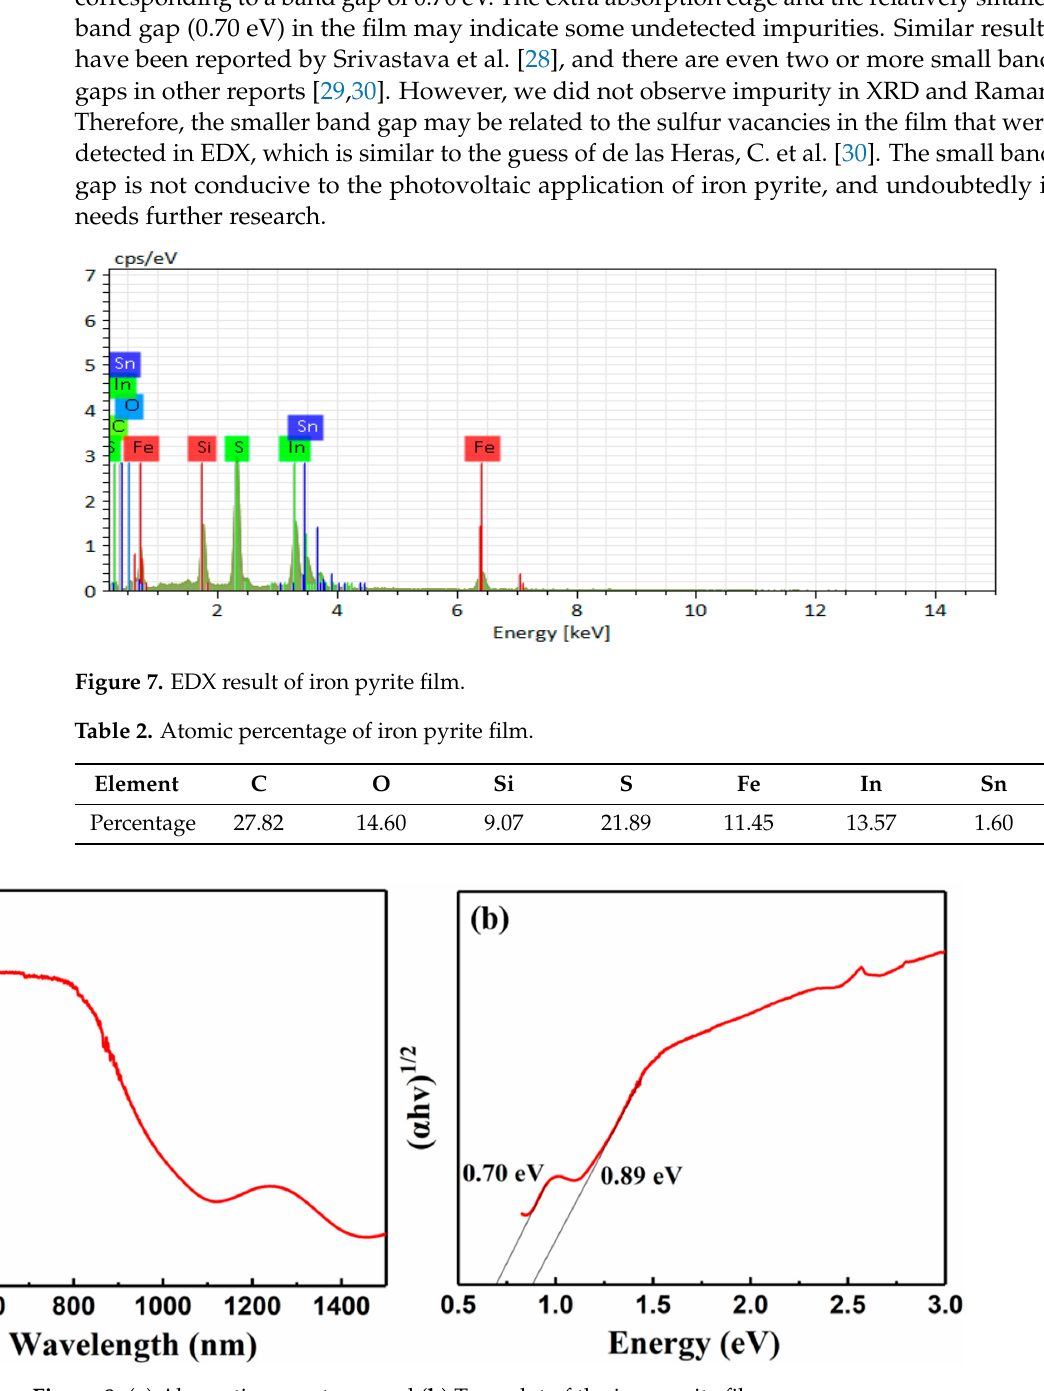
Table 2. Atomic percentage of iron pyrite film.